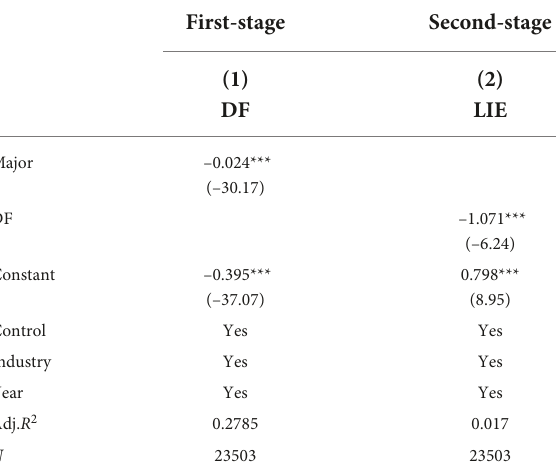
TABLE 8 Instrumental variables tests. TABLE 10 Influencing mechanism tests.